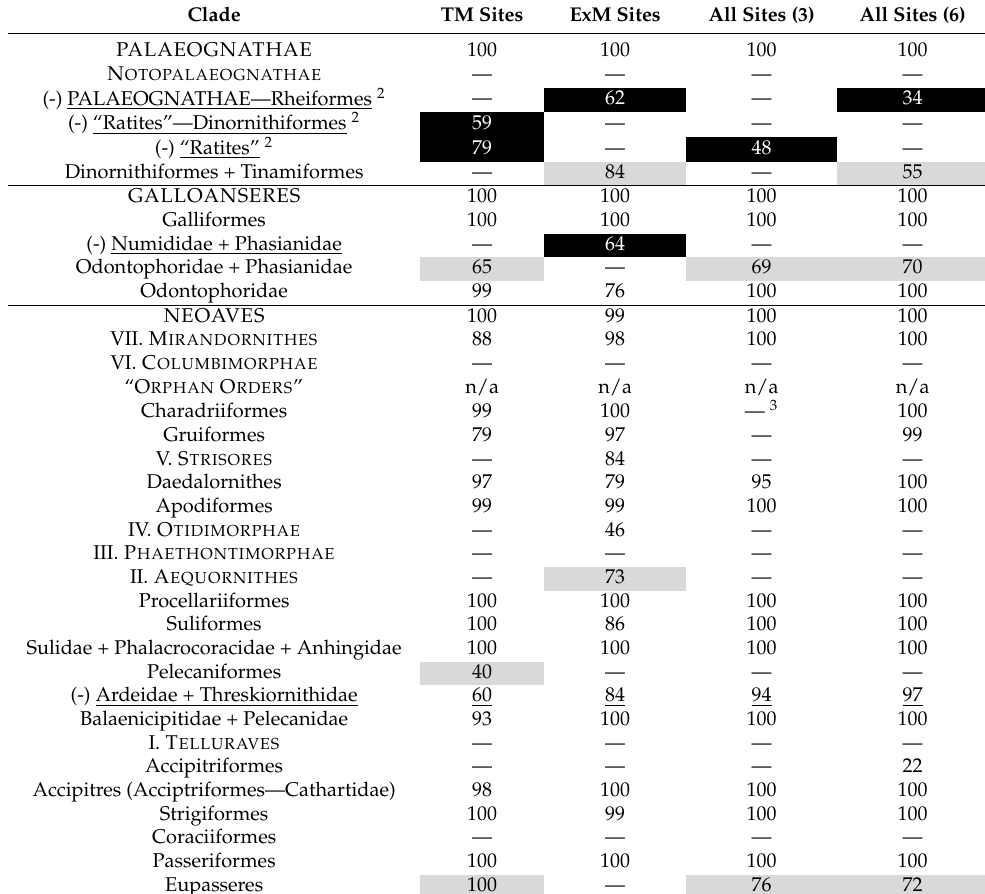
1 We have shaded support values when analyses of the data subsets disagree. Cells were shaded light gray if they agree with our best estimate of the avian species tree and black with white text if they conflict with our best estimate of the avian species tree. 2 We have added two groups that are unlikely to be correct because they appeared in nucleotide analyses and they relate to the topology for Palaeognathe (see discussion for additional information). 3 All Charadriiformes except Turnix sylvaticus form a clade with 100% support in the three-partition nucleotide analysis of all sites. The family Turnicidae (hemipodes) has a long branch in many analyses of molecular data